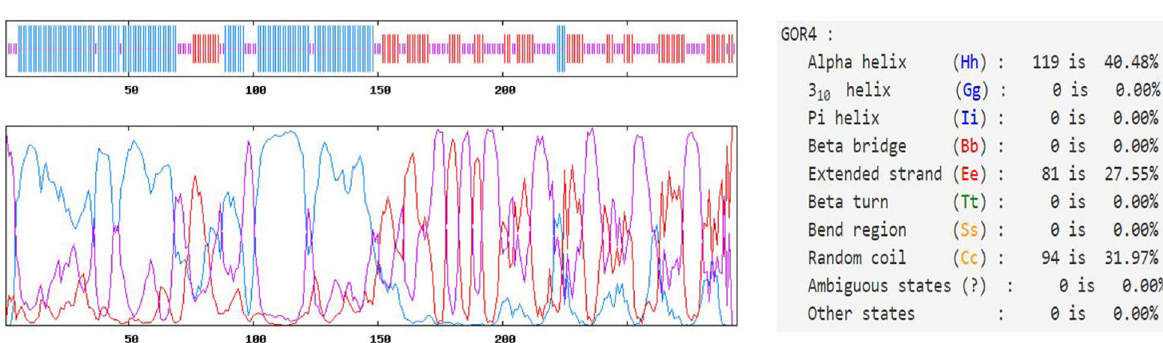
Figure 3. The graphical representation of the secondary structure configuration of the multi-epitope